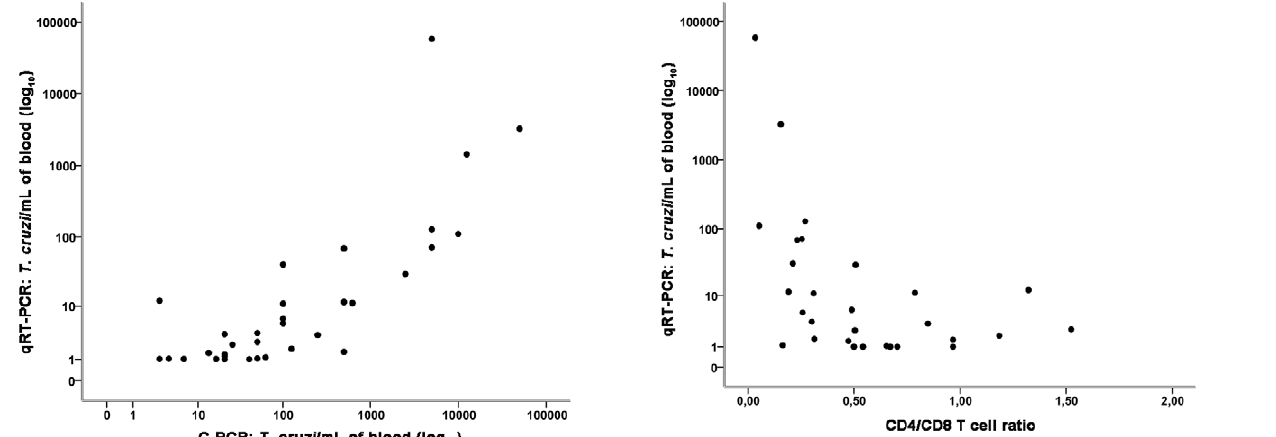
Figure 4. Correlation between number of parasites/mL of blood by competitive PCR (C-PCR) and real-time PCR (qRT- PCR). Correlation between number of T. cruzi /mL in 38 paired samples from patients infected with HIV/ T. cruzi with or without Chagas disease reactivation. Spearman’s correlation index ( r s )= 2 0.725, P , 0.001.